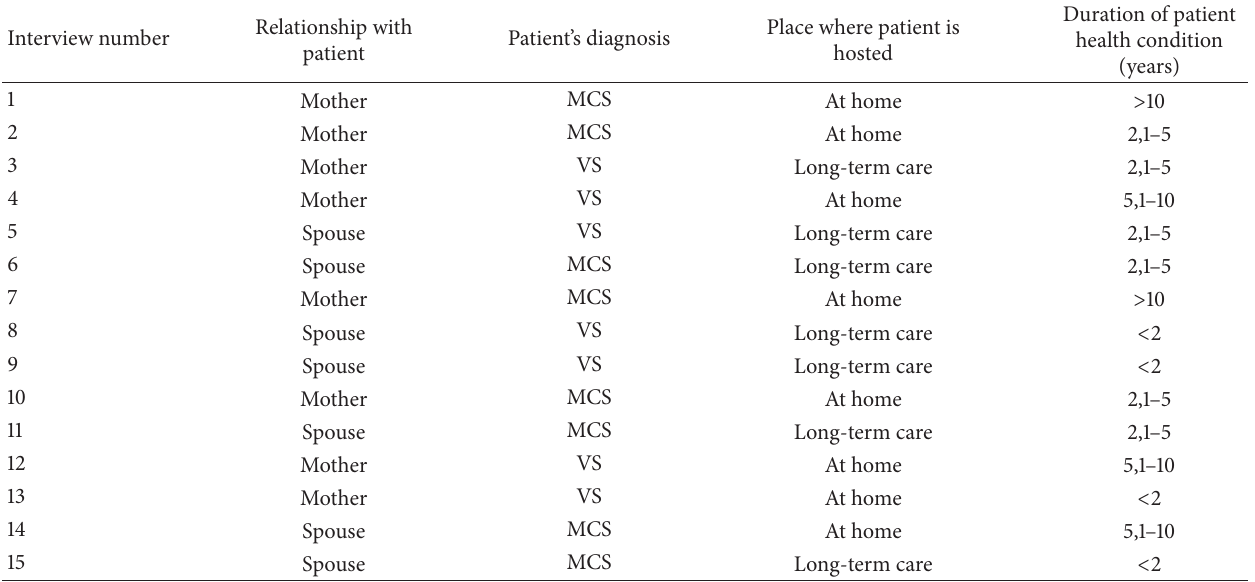
Table 2: Details on caregivers interviewed in chronological